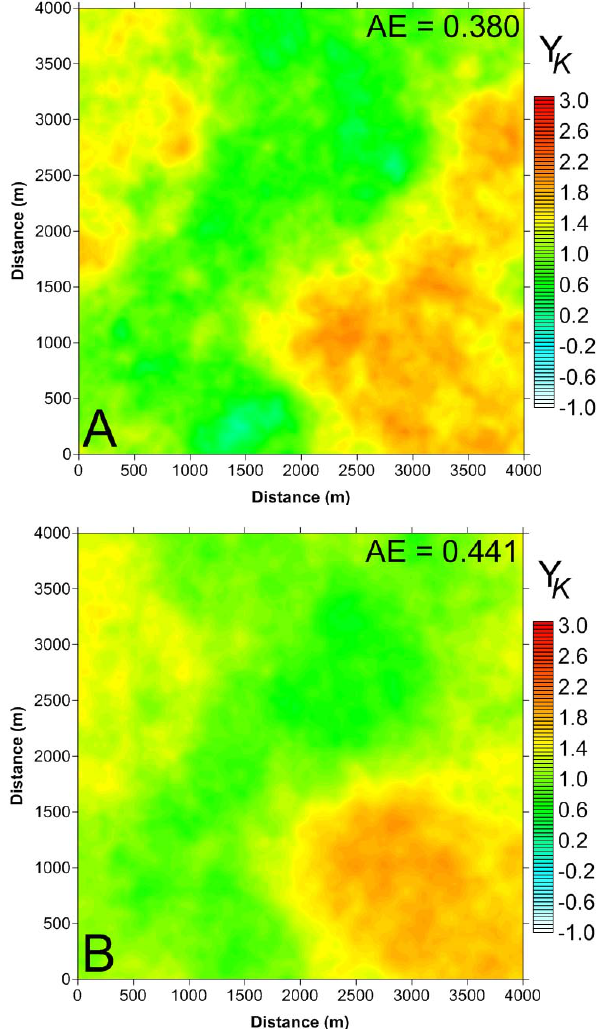
Fig. 6. Spatial distribution of the updated Y K ensemble using data from 24 observation wells sampled 4 times during the 365-day pe- riod, with the CV of observation data set to (A) 0.0 and (B) 0.3. Compare to the true state shown in Figure